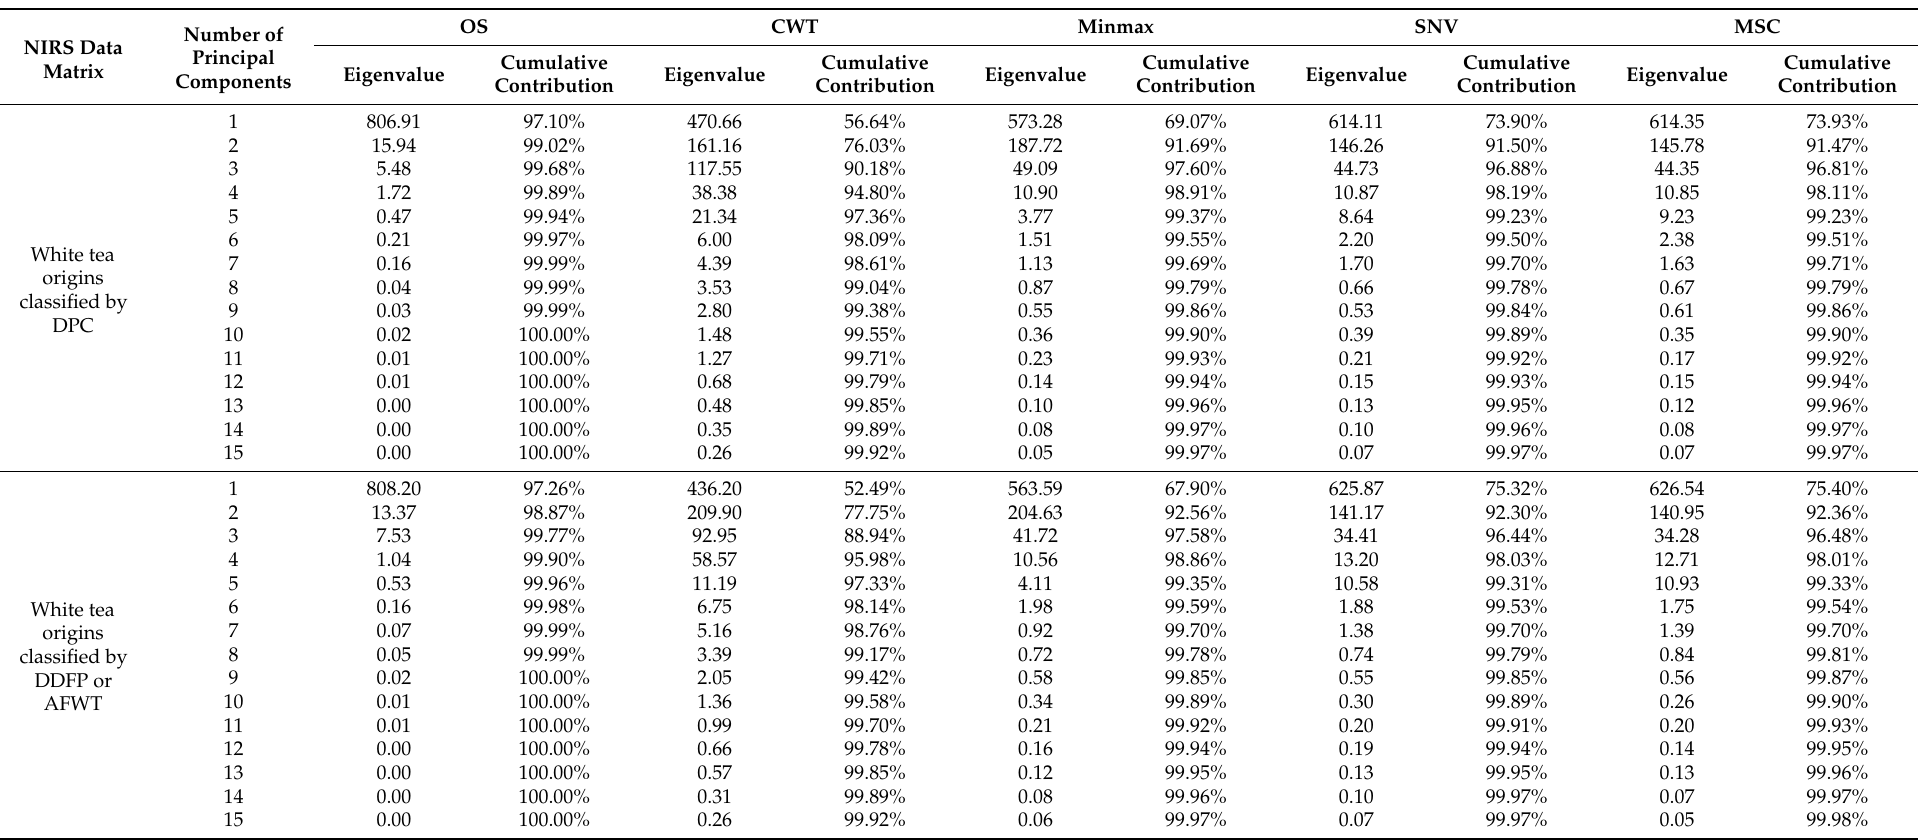
Table 1. PCA eigenvalues and cumulative